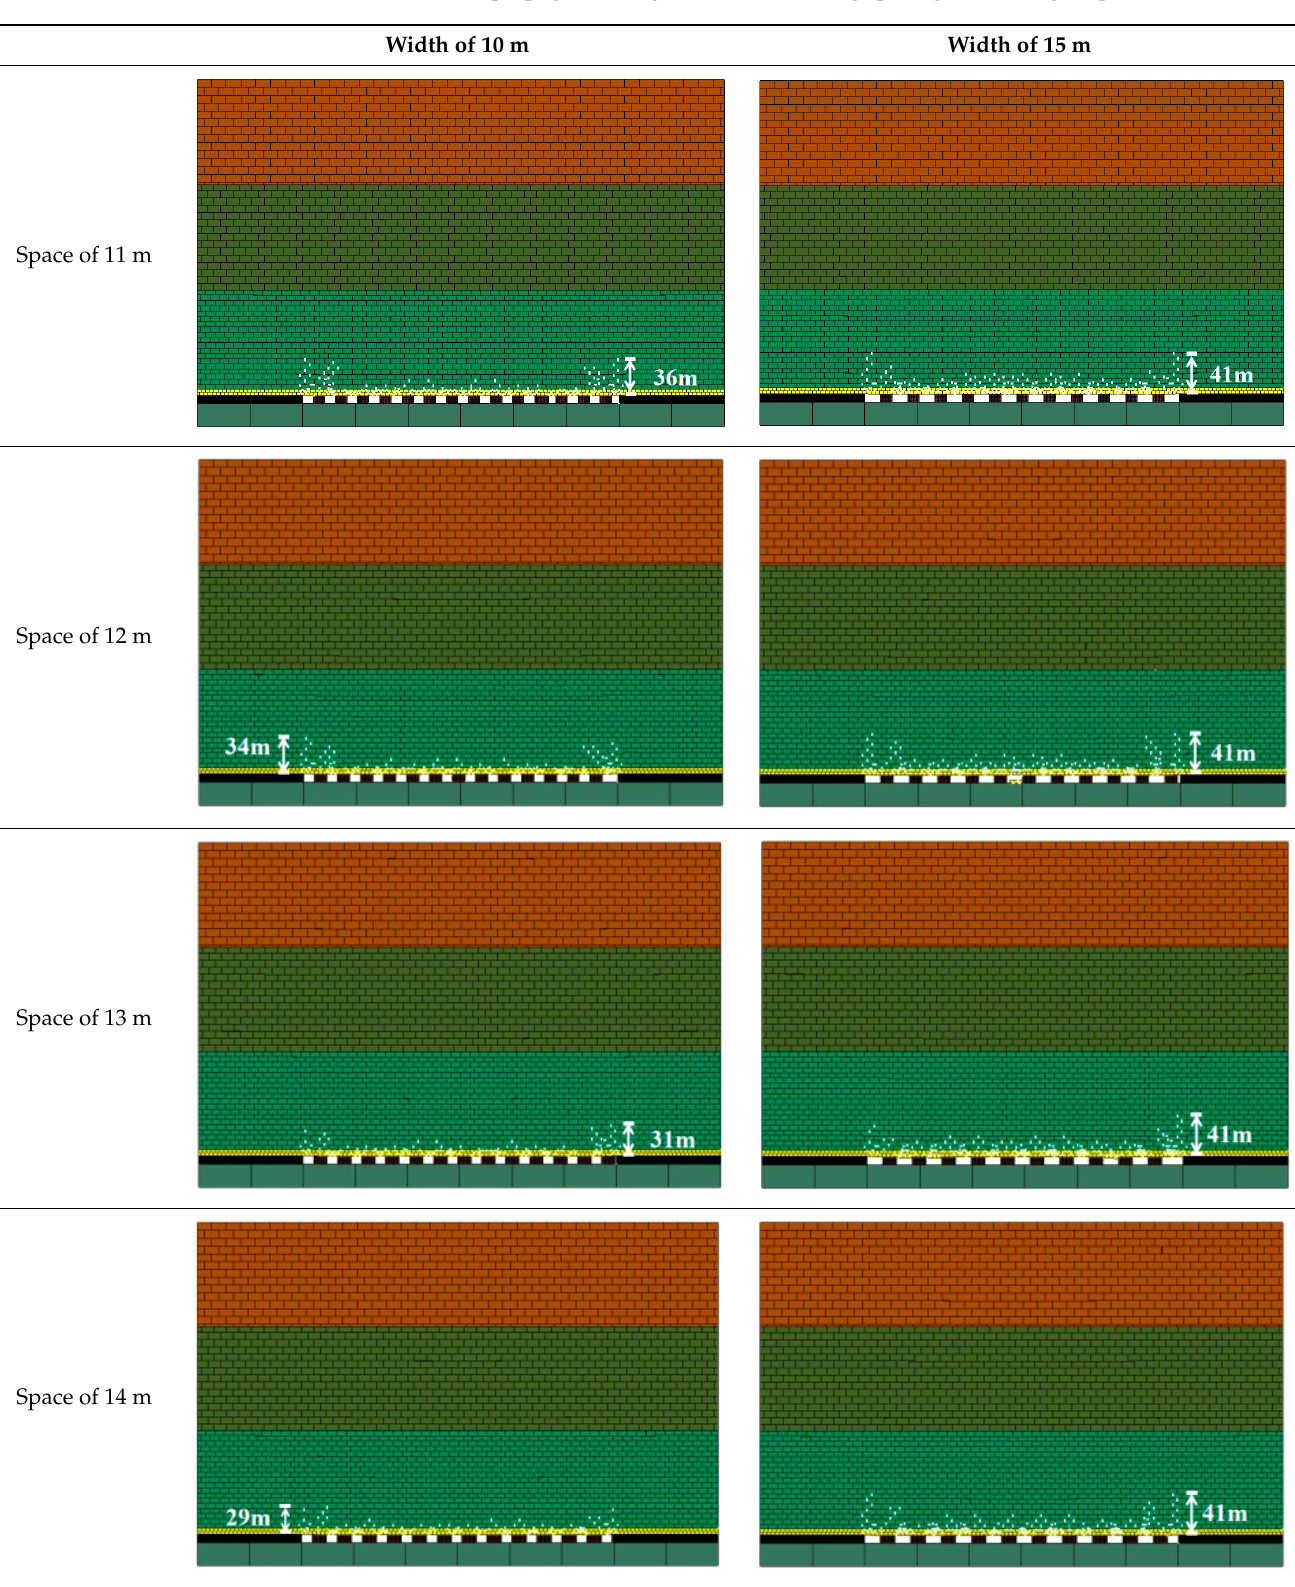
Table 4. Fracture propagation height of different filling spacings and filling strip